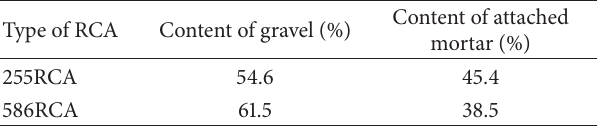
Table 2: Contents of gravel and attached mortar in RCA by